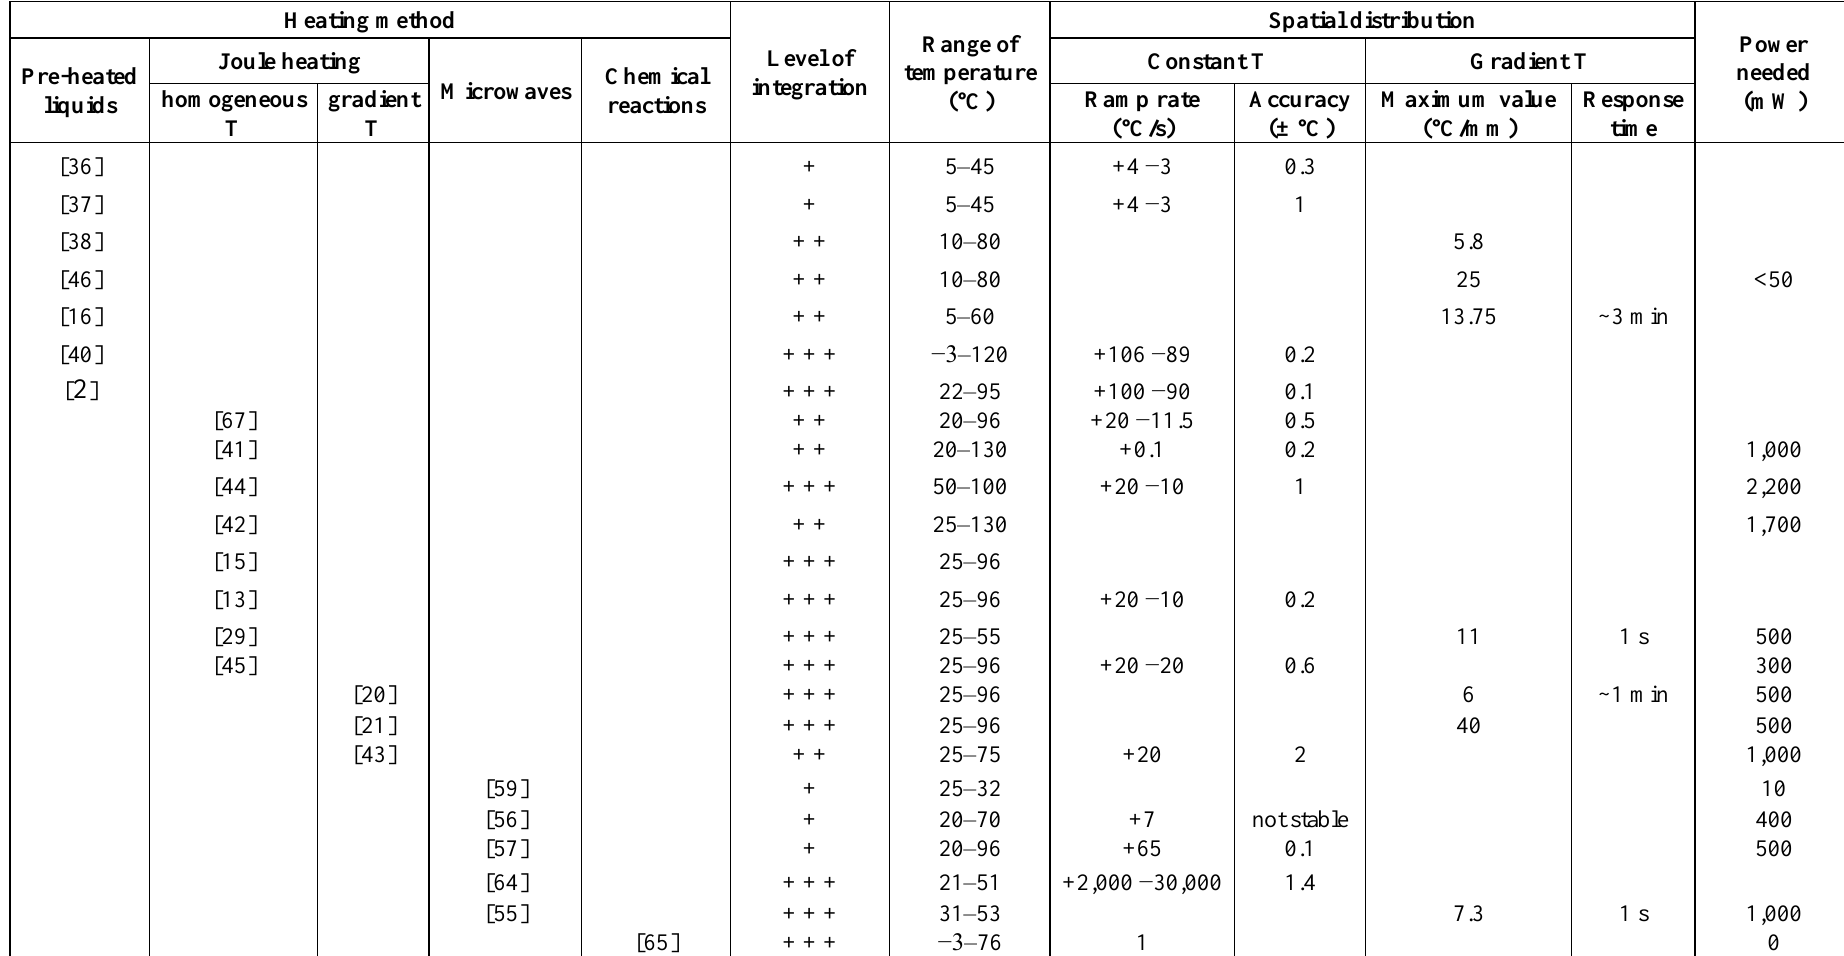
Table 1. Summary of the specifications related to the techniques discussed in the